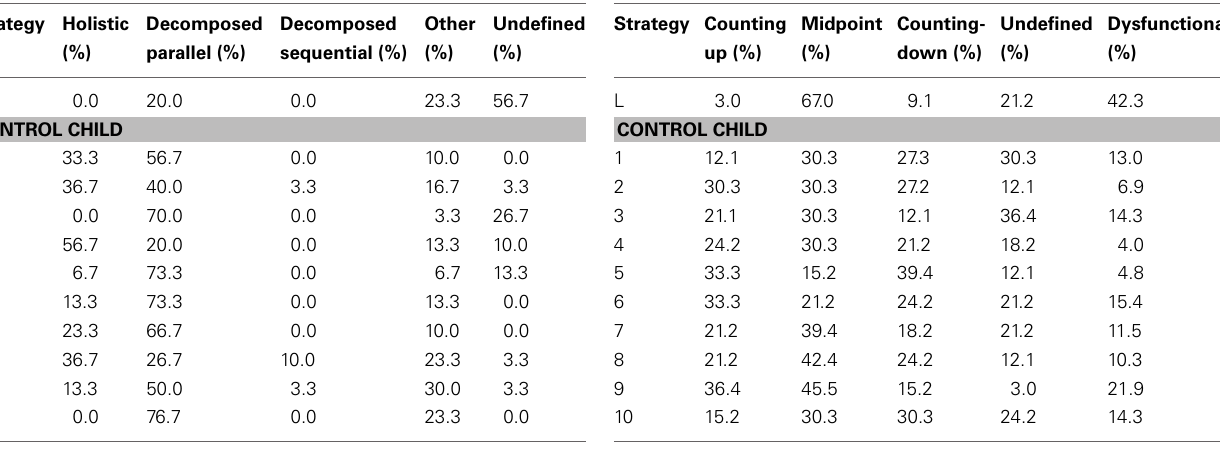
Table A7 | Overview of the individual percentages of the estimation strategies in the symbolic 0–1000 number line task of the child with dyscalculia and the control